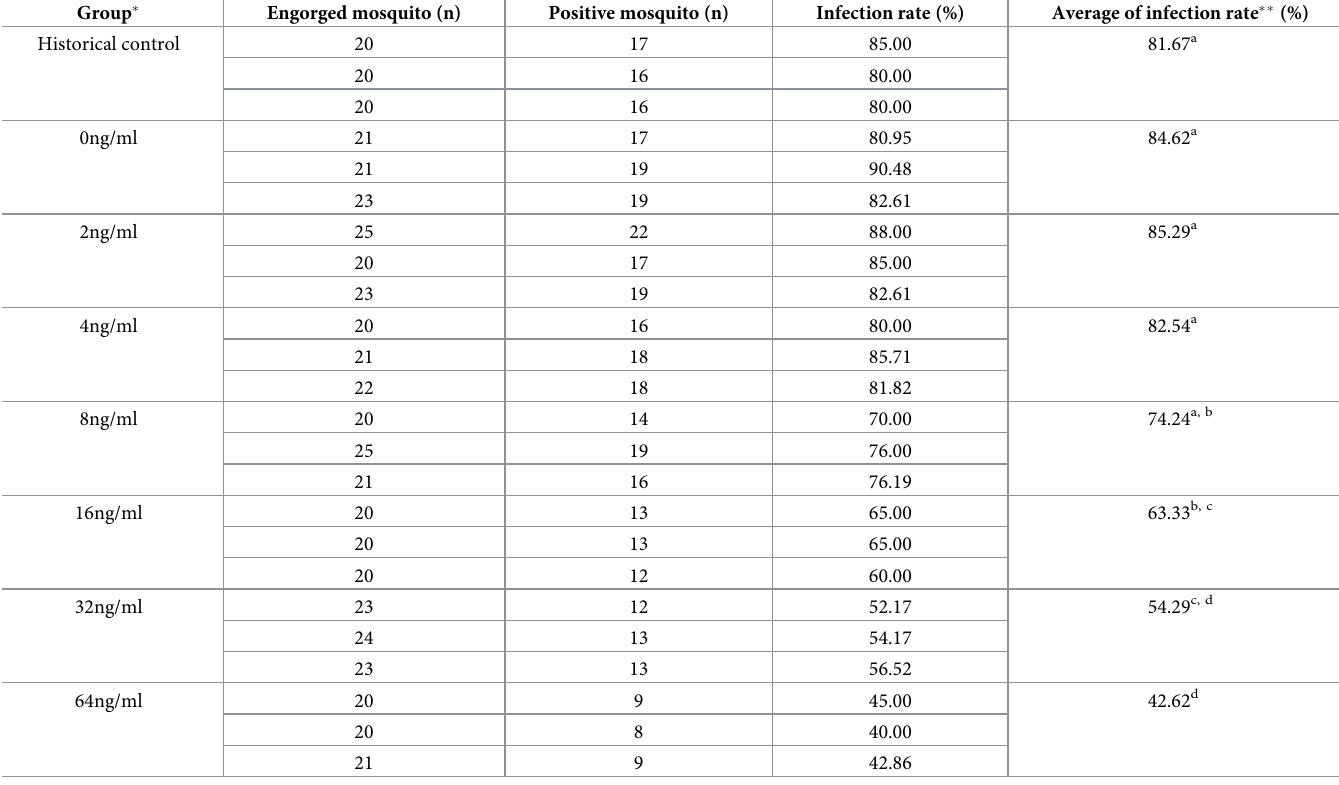
Table 1. Pair-wise differences of infection rates among the eight groups. Group � Engorged mosquito (n) Historical control